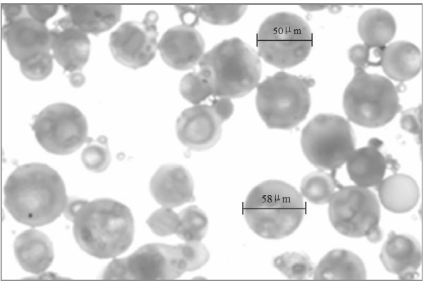
Figure 5: The micromorphology of OPPTA at room temperature.